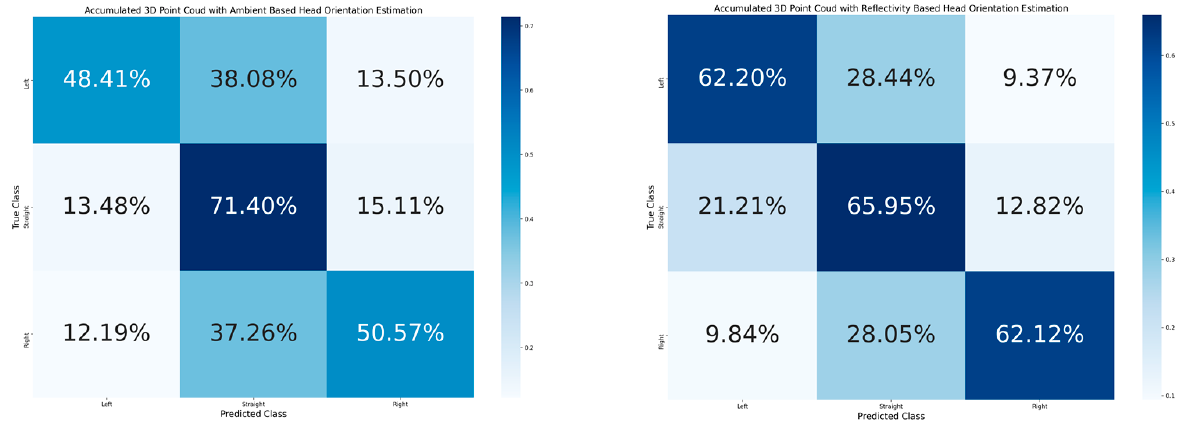
Figure 10. Left : Confusion matrix of head orientation estimation accumulated from joined body and head orientation estimation using 3D point cloud data with ambient. Right : Confusion matrix of head orientation estimation accumulated from joined body and head orientation estimation using 3D point cloud data with reflectivity.